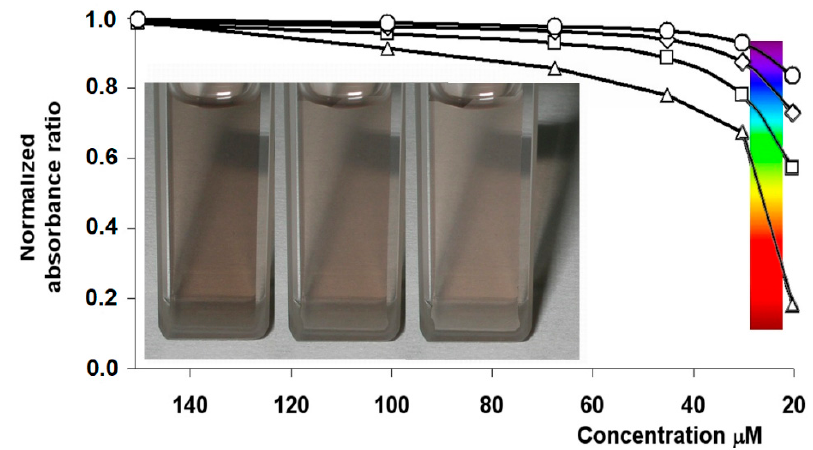
Figure 5. Normalized plots of the absorbance ratios Ax/A314 at selected wavelengths ( 384 nm, 420 nm, 550 nm, and 750 nm) as a function of dilution of soluble eumelanin (for all wavelengths, normalization was obtained by dividing all absorbance ratios by the relevant value at 150 mM concentration).